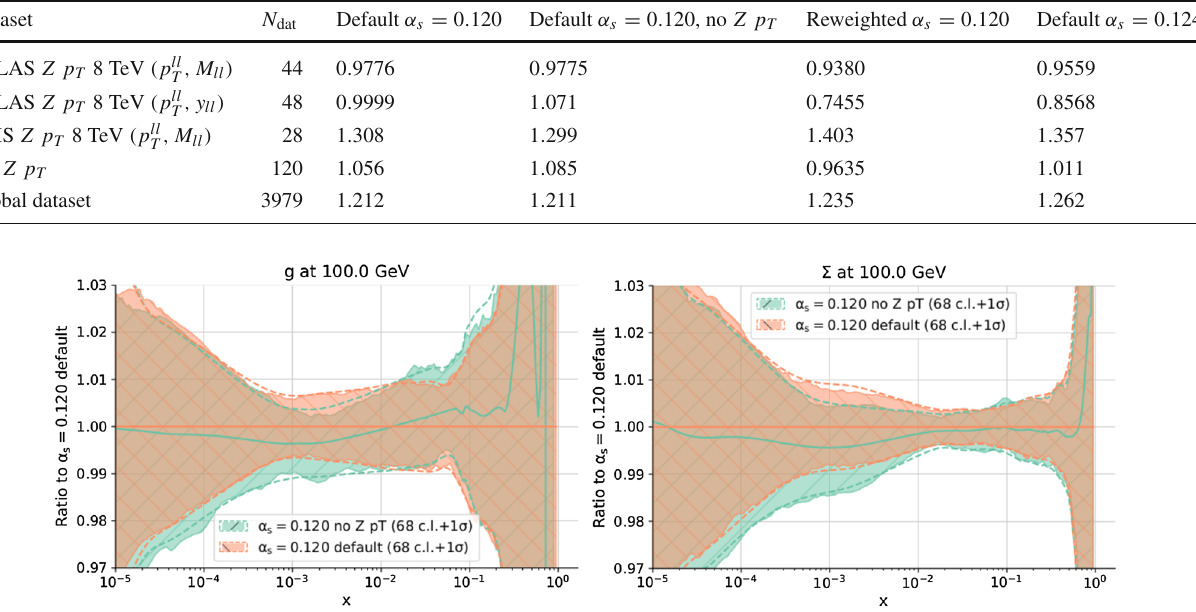
Fig. 4 Same as Fig. 3, but now comparing the global fit (same as shown in Fig. 3) to a global fit from which the Z p T data have been removed, shown as a ratio to the